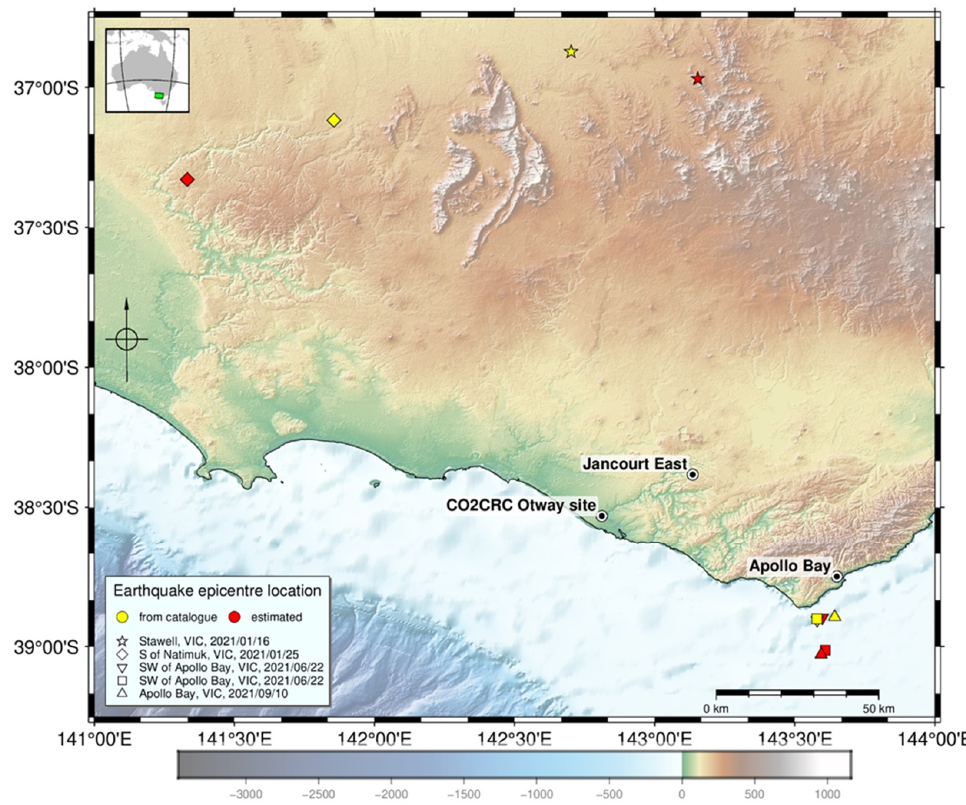
Figure 5. Misfit between locations of events from GA catalogue (yellow) and DAS data analysis (red).